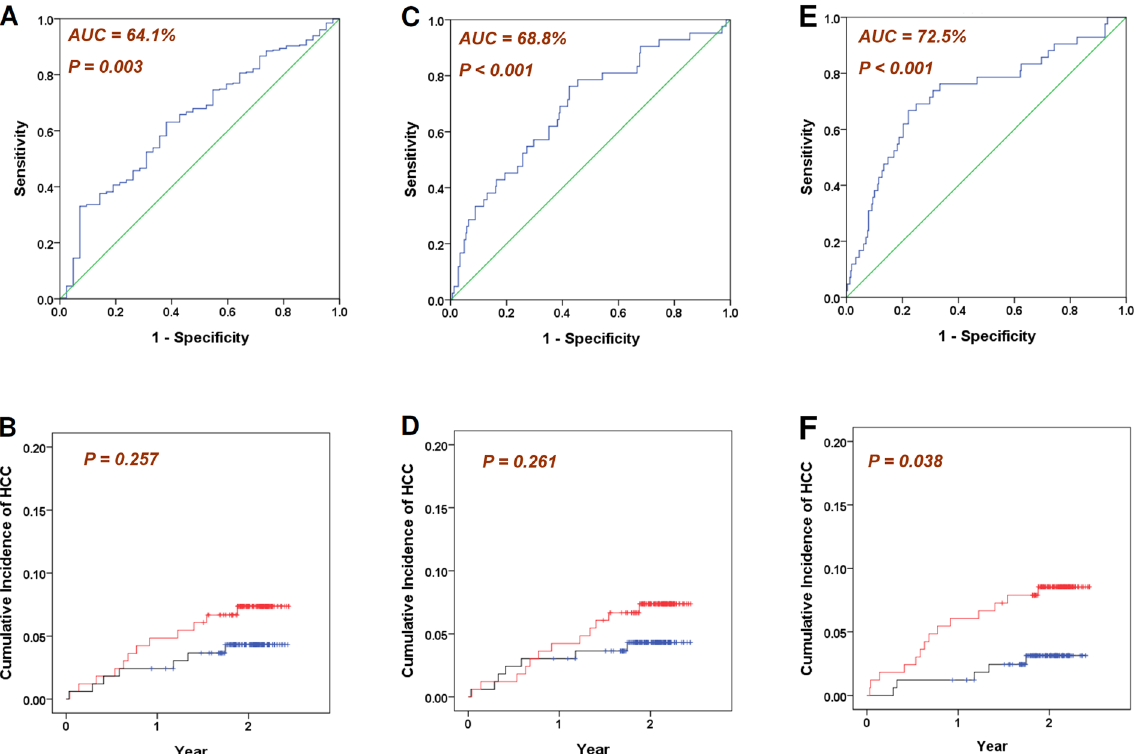
Figure 2. Cross-sectional classification and longitudinal time-to-HCC analysis of three different models. ( A ) and ( B ): based on miRNA-15a level only; ( C ) and ( D ): based on the logistic regression model incorporating 12 miRNAs; ( E ) and ( F ): based on the proposed HCC Risk score. Red: the cumulative incidence of the higher-risk patient stratum (N = 165); Blue: the cumulative incidence of the lower-risk patient stratum (N =